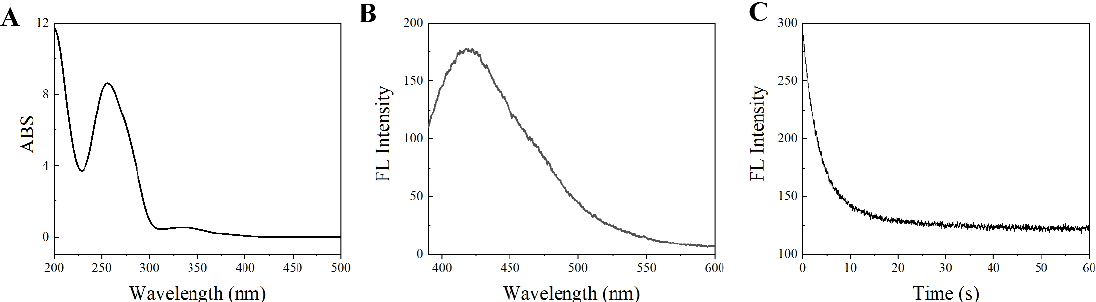
Figure 3. UV/Vis absorption spectrum ( A ), fluorescence emission spectrum ( B ), and fluorescence attenuation curve ( C ) of